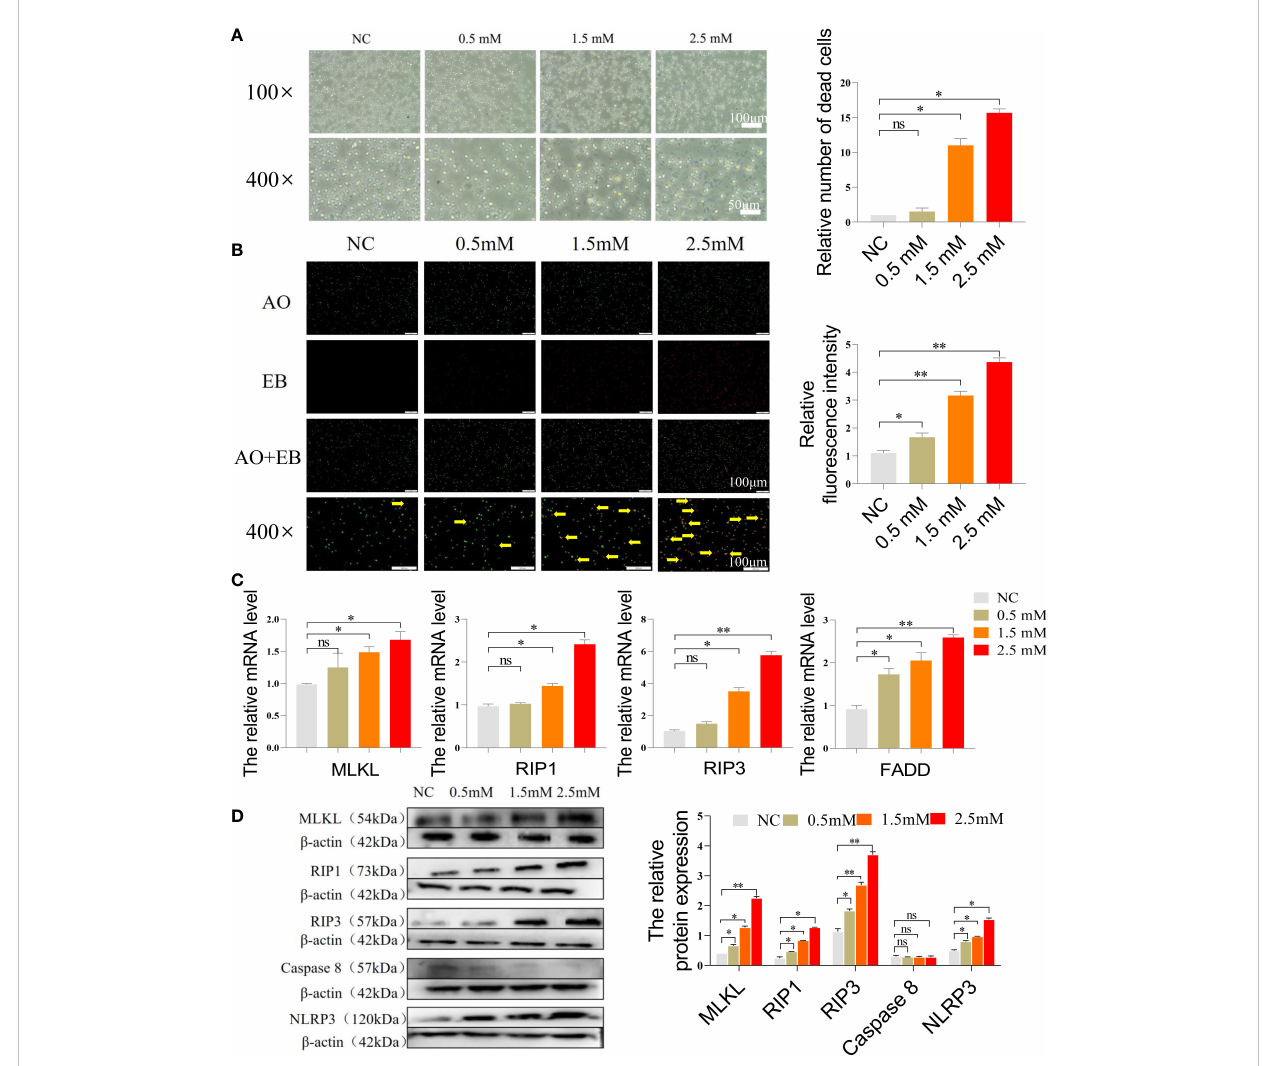
FIGURE 3 (A) Microscopic morphology of cells after exposure to different concentrations of NiCl 2 , green dots represent normal cells and red dots pointed by the yellow arrow represent necroptosis cells. (C) The mRNA expression of necroptosis-related genes in spleen lymphocytes exposed to different concentrations of NiCl 2 . ns represents no statistical difference between the two groups, * represents signi fi cant difference between the two groups (P<0.05), and ** represents extremely signi fi cant difference between the two groups (P<0.01). (D) The protein expression of necroptosis-related genes in spleen lymphocytes exposed to different concentrations of NiCl 2